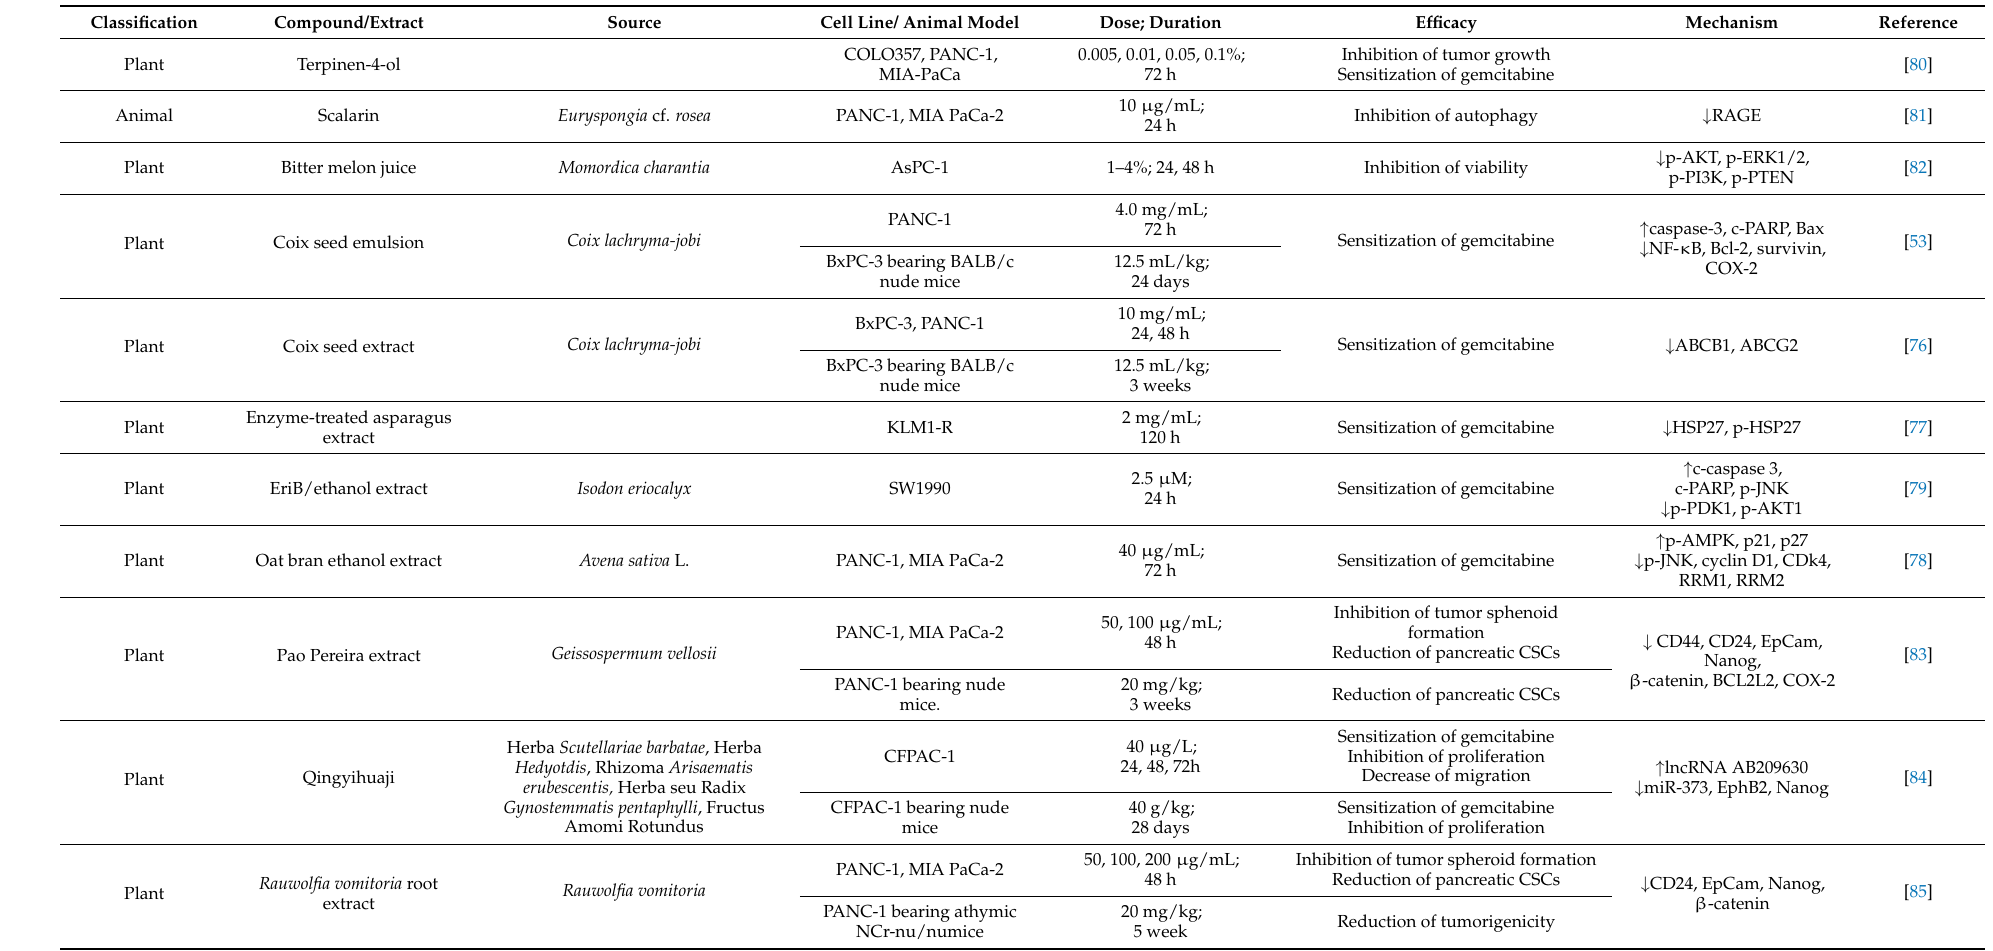
Table 6. Resistance inhibiting natural